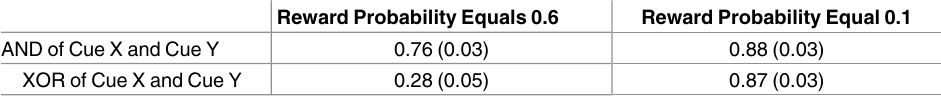
Table 2. The mean R 2 (with standard deviations) between network responses and actual probabilities for 16 different input patterns in each of the four types of training sets. Reward Probability Equals